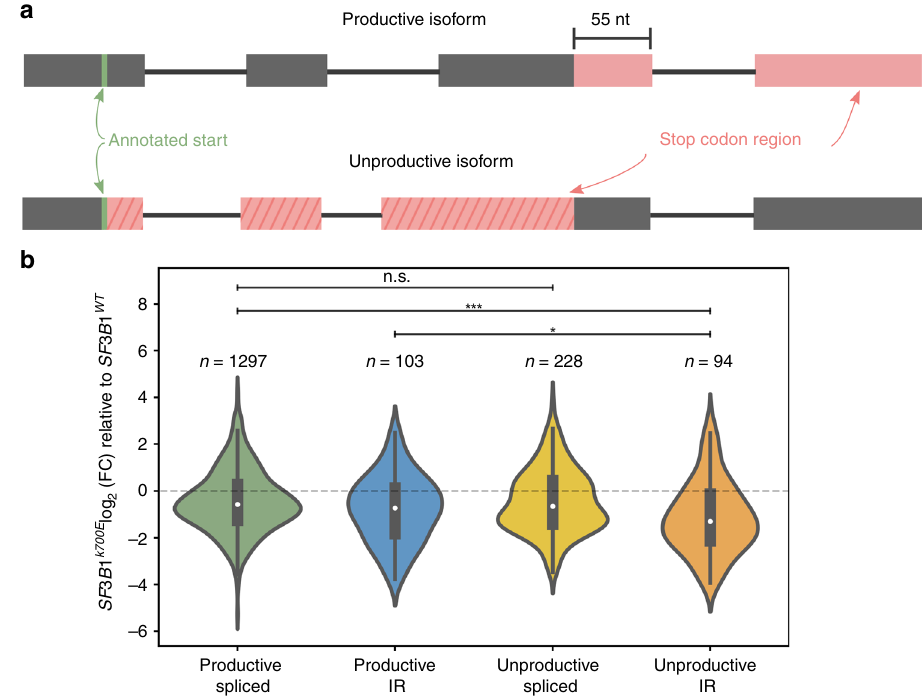
Fig. 5 Mutant SF3B1 downregulates unproductive, intron-retaining transcripts. a Schematic of productive and unproductive isoforms. The region on an isoform where stop codons can occur is colored red. Unproductive isoforms have premature stop codons present 55 nt or more from the last splice junction. b Expression fold-change (FC) between SF3B1 K700E and SF3B1 WT of FLAIR isoforms categorized as containing (IR) or not containing (spliced) retained introns and by productivity. The difference between the log2(FC) of the productive spliced and the unproductive-IR categories is 0.720. Violin plot show median as white dot, box limits are upper and lower quartile, and fi lled area represents the entire range of the kernel density estimation. * p value <